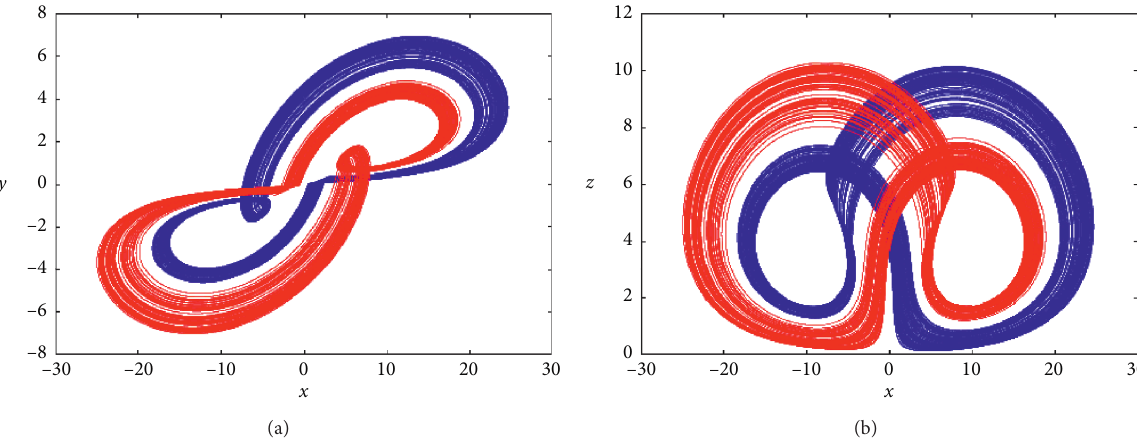
Figure 4: Phase portraits of coexisting attractors in (a) x − y and (b) x − z planes (the blue one starts from initial conditions ( 1 , 0 , 0 , 22 ) and the red one starts from ( 1 , 0 , 0 , − 22 ) ).